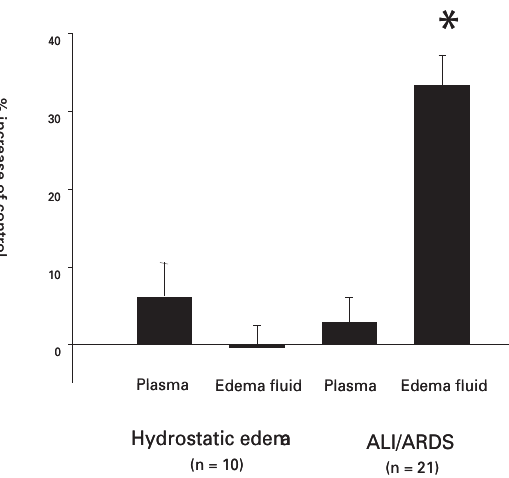
Effect of pulmonary oedema fluid and plasma from patients with ALI/ARDS or hy- drostatic pulmonary oedema on alveolar epithelial repair in vitro . The epithelial repair activity of pul- monary oedema fluid or plasma was deter- mined for each sam- ple using an in vitro epithelial wound re- pair assay with human A549 alveolar epithelial cells and expressed as the percentage increase of alveolar epithelial repair compared to pooled plasma from healthy donors (con- trol). Results are re- ported as mean ± SEM, *p <0.01 (com- pared to control). From